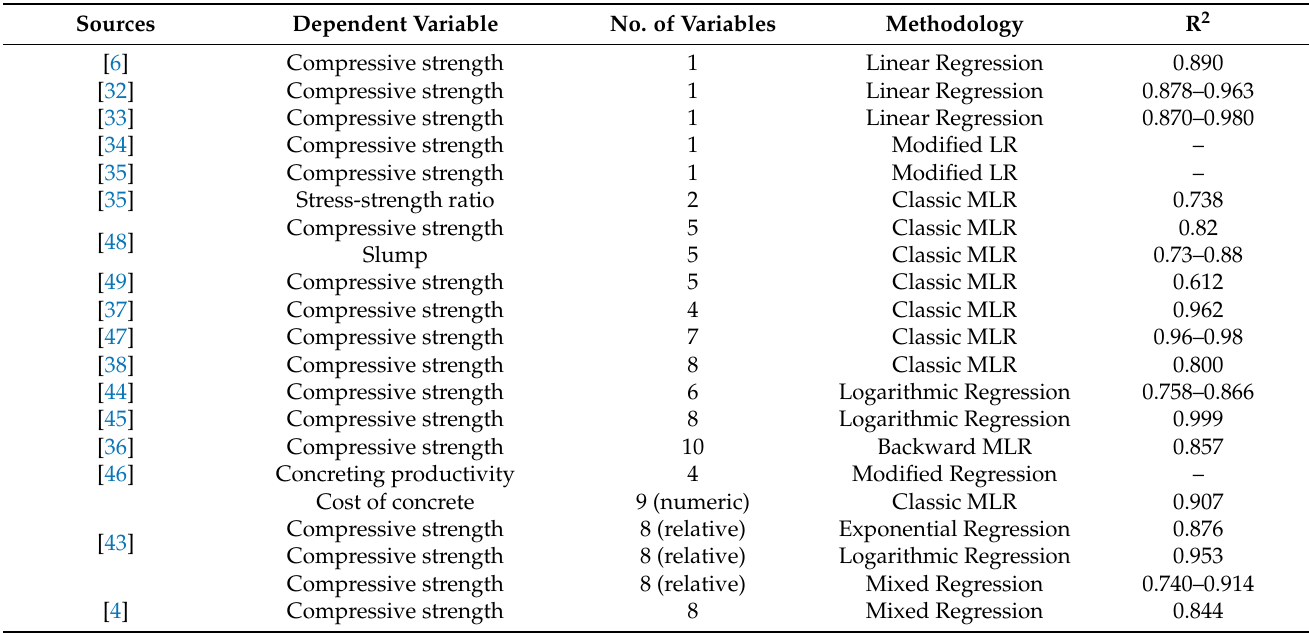
Table 2. Application of regression